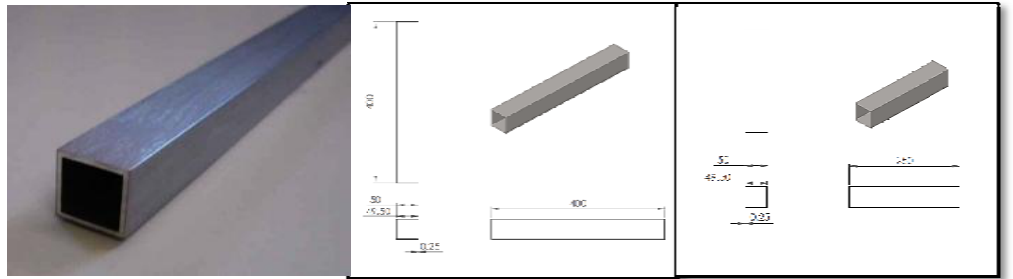
Fig. 3. Link Form Stainless Steel.